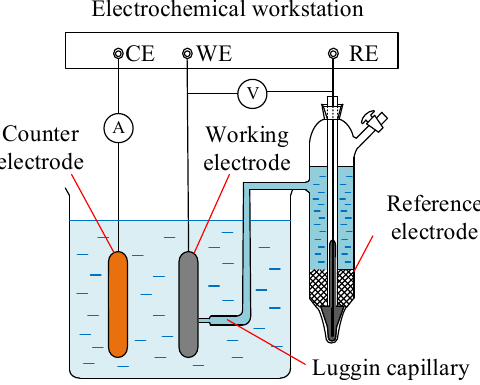
Figure 2. Typical three-electrode system for measuring polarization